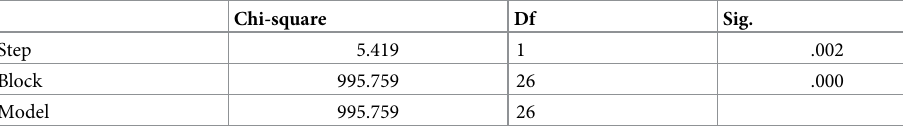
Table 5. Omnibus tests of model